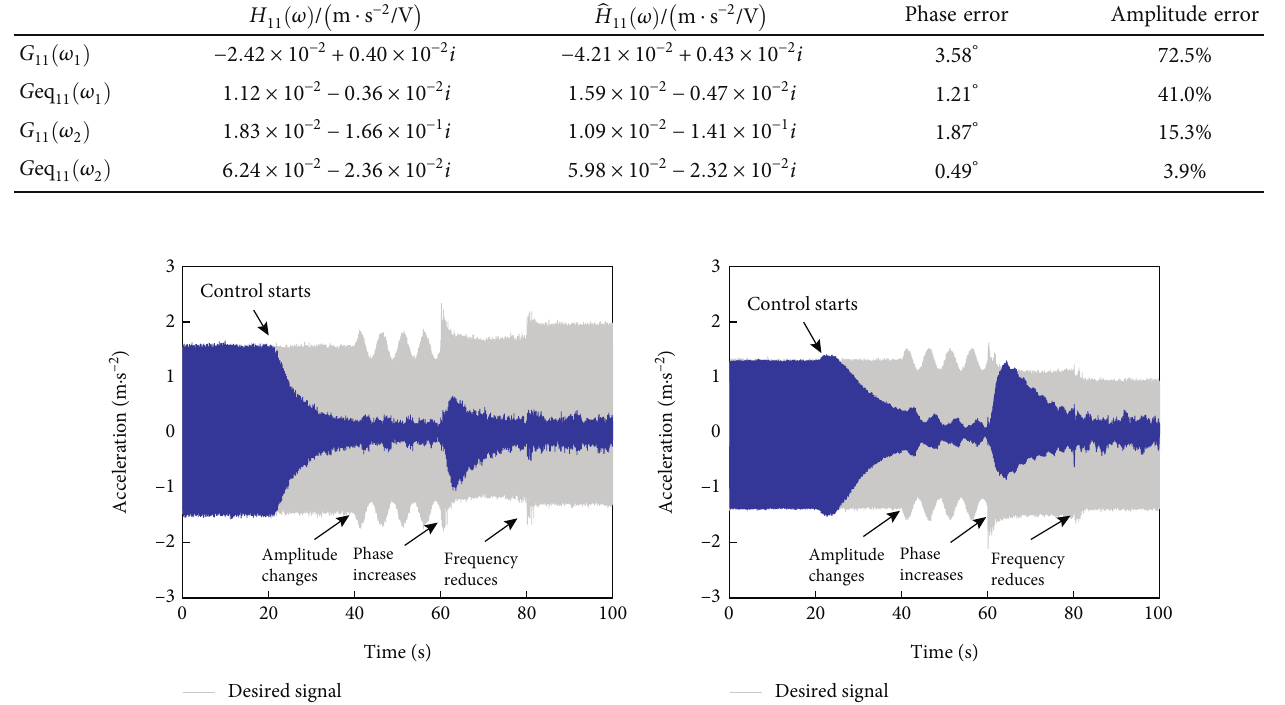
ð ω Þ and G eq ð ω Þ before and after system parameter Table 5: G 11 11